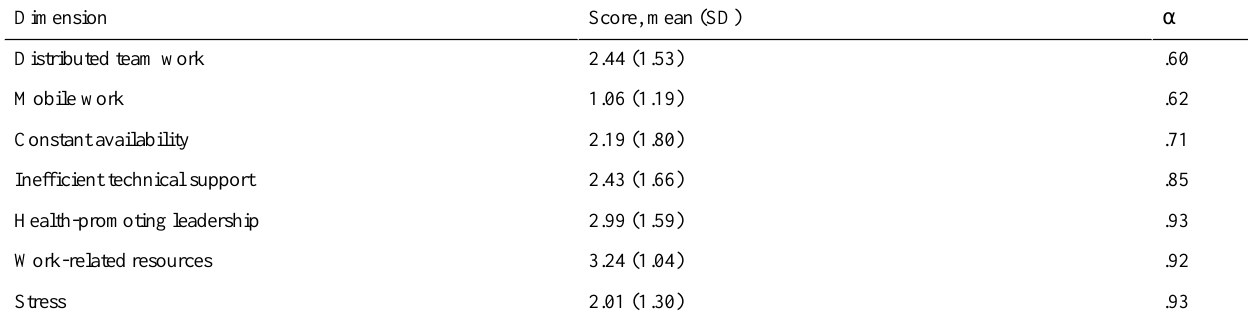
Table 2. Descriptive statistics and reliabilities of the study